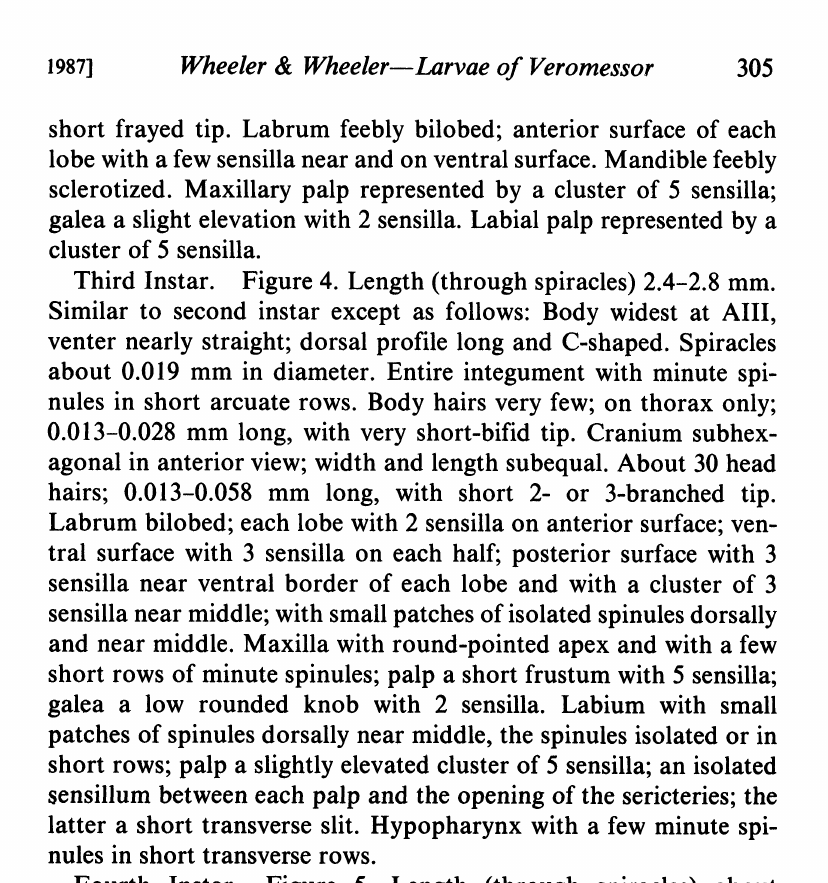
Figure 4. Length (through spiracles) 2.4-2.8 mm.